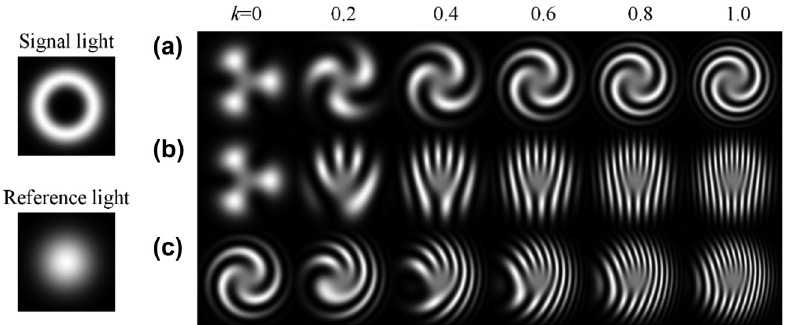
Figure 1: Interference patterns of a pure third azimuthal order vortex light when fixing (a) k x = 0, (b) k r = 0, (c) k r = 0 . 6 and scanning another k from 0 to